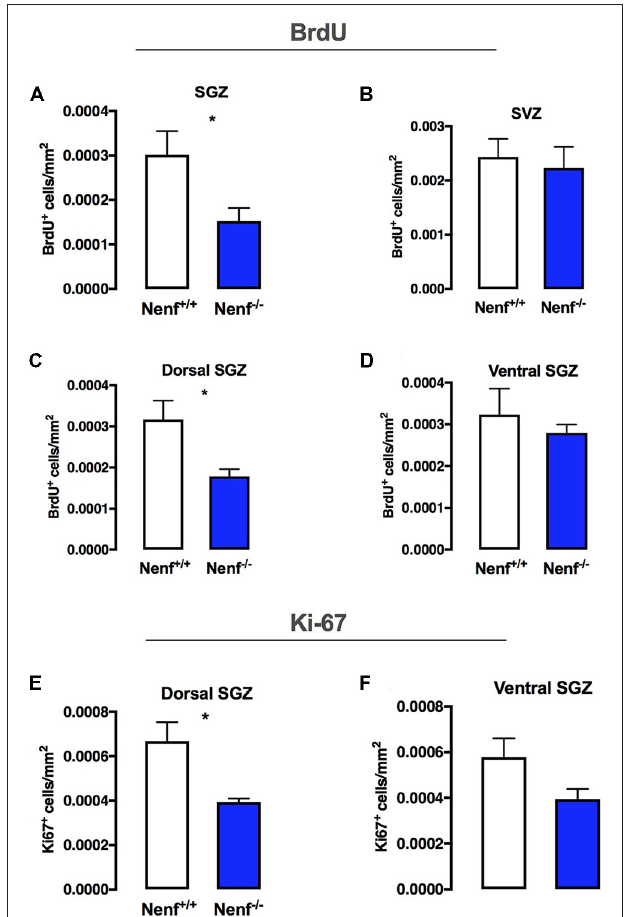
FIGURE 1 | Neudesin ablation decreases proliferation selectively in the dorsal hippocampus. BrdU labeling for 24 h in the total sub-granular zone SGZ revealed that neuron-derived neurotrophic factor (NENF) ablation decreases proliferation (A) . NENF − / − mice, when compared to the respective littermate controls, did not show proliferative rate differences in the subventricular zone (SVZ; B ). When considering the SGZ divisions, dorsal (C) and ventral (D) , the effect of NENF is restricted to the dorsal pole although a slight decrease is also observed in the ventral pole of Nenf − / − males but not significant. Ki67 positive cell counts in the dorsal (E) and ventral (D) SGZ, showed a selective significant decrease in proliferation of NENF − / − mice in the dorsal area. Data presented as Mean ± SEM analyzed by two-tailed Student’s t -test. ∗ p < 0.05.